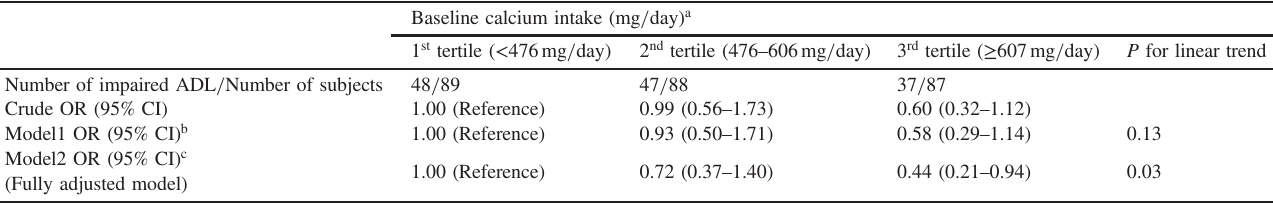
Table 2. Relation between calcium intake and impaired activities of daily living (ADL) in 2000 ( n = 264; 132 pairs)